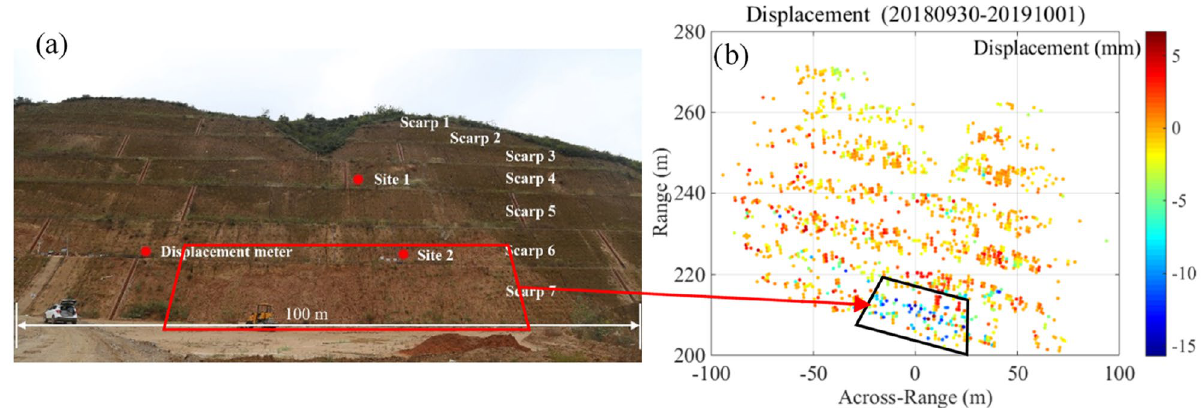
Figure 7. Slope deformation between 30 September 2018 and 1 October 2019. The red ( a ) and black ( b ) rectangles indicate the area showing non-recoverable deformation. Negative values are out-of-slope deformation.